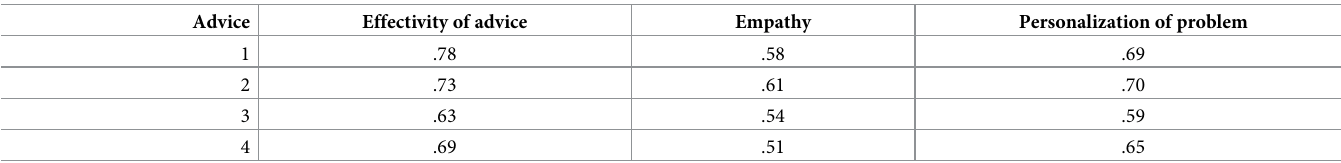
Table 8. Interrater reliability of the coders’ evaluations of the pieces of advice—linearly weighted kappa (the emotional problem-solving study).